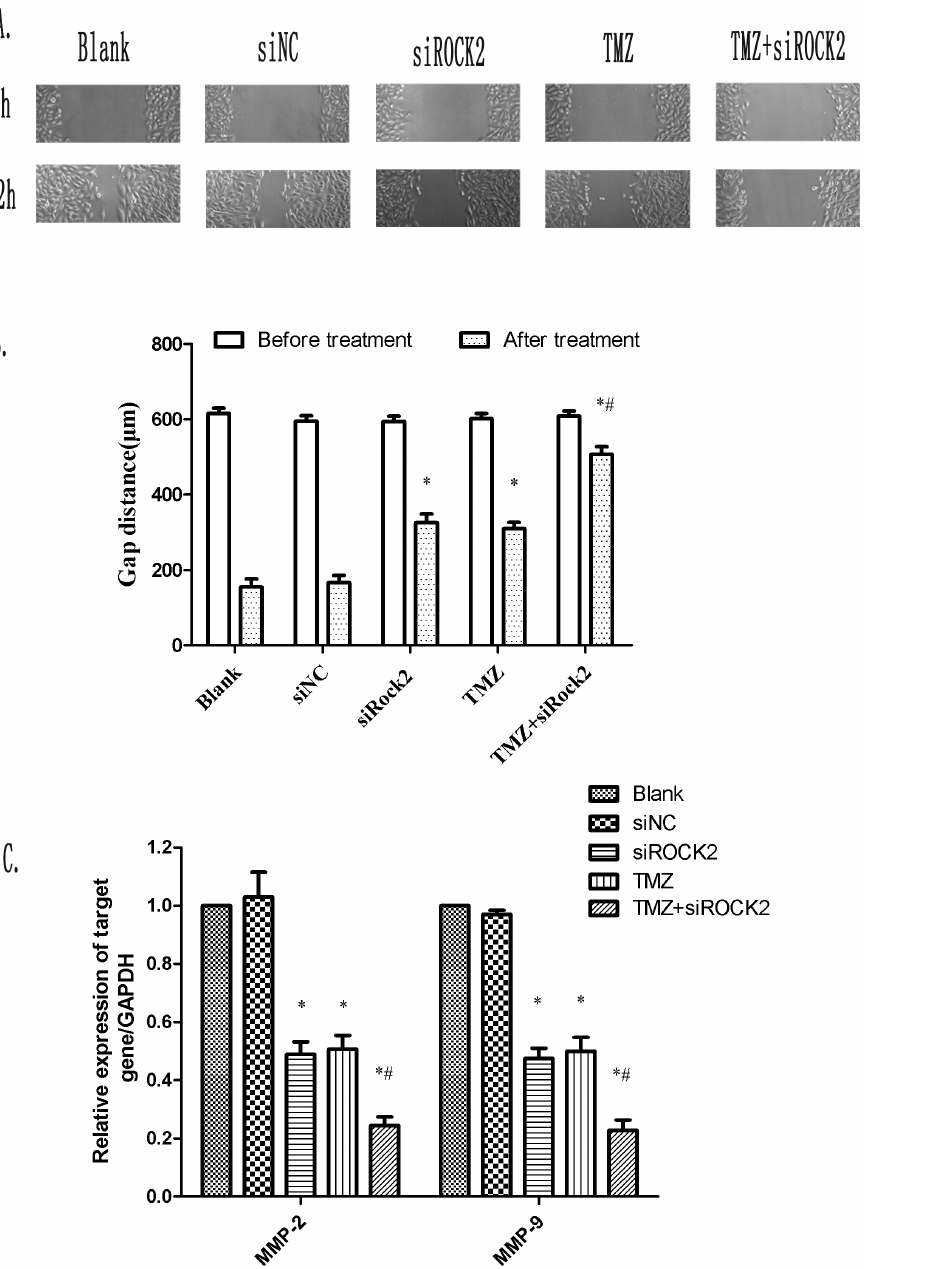
Figure 6. Combination treatment with TMZ and siROCK2 prevents cell migration in the wound-healing assay. A The images were captured using a phase contrast microscope at 0 and 12 h. U251 cells were treated with siNC, siROCK2 complex, TMZ (100 m M), or the combination of siROCK2 complex and TMZ (100 m M) for 12 h. B The gap distance was measured using the ImageJ software and is presented in the bar graph. C Measurement of the mRNA levels of MMP-2 and MMP-9 after treatment for 12 h. The data are presented as the means 6 SD; n=3. * P , 0.05 compared with the blank; # P , 0.05 compared with siROCK2 or TMZ.